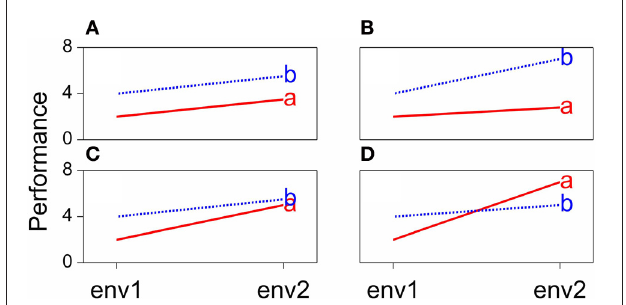
FIGURE 1 | Genotype-by-environmentinteraction in terms of changing mean performances across environments: (A) additive model, (B) divergence, (C) convergence, (D) cross-over interaction.